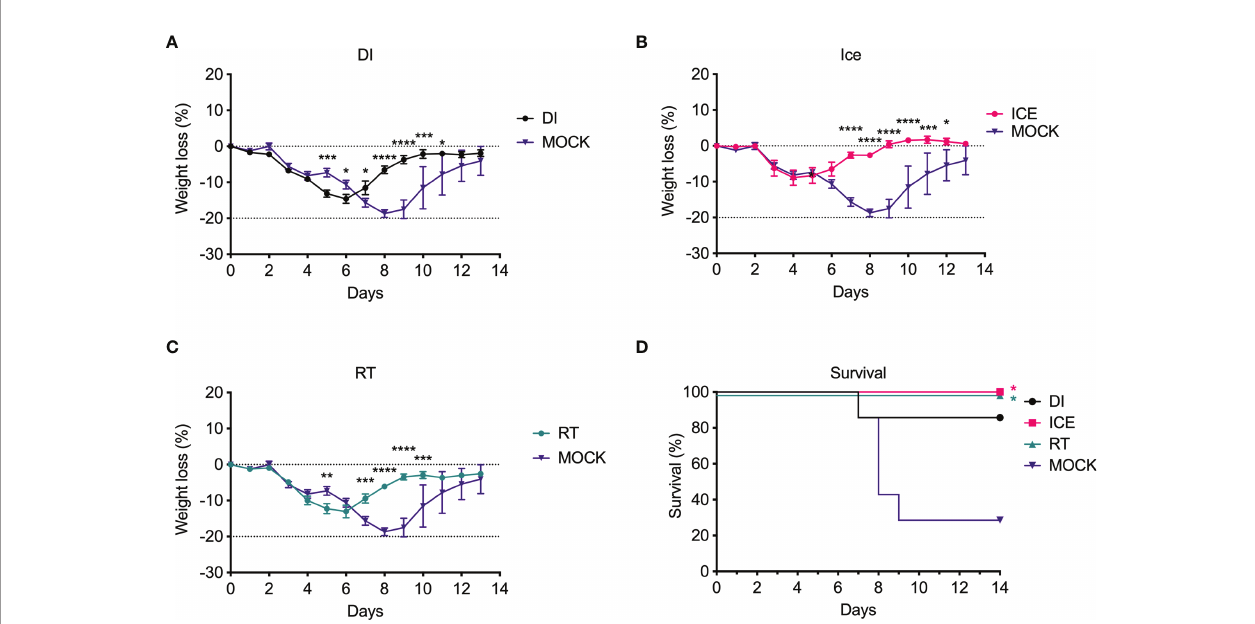
FIGURE 6 | Vaccination with g -Flu protects against lethal challenge with a drifted IAV strain. Mice were vaccinated intranasally with g -Flu ( g -A/PR8 H1N1) irradiated at different temperatures, or PBS as mock control. 21 days later mice were challenged intranasally with a lethal dose of A/California H1N1. (A-C) Weight loss was measured daily, with a 20% loss of starting weight (dotted line) was considered as the humane end point. Weight loss was analysed by Two-Way ANOVA. (D) Survival rates were plotted, and a Two-Tailed Fisher-Exact test was used for analysis by comparing vaccinated groups to the PBS-MOCK vaccinated group (*p < 0.05, **p < 0.01, ***p < 0.001, ****p < 0.0001), n = 7